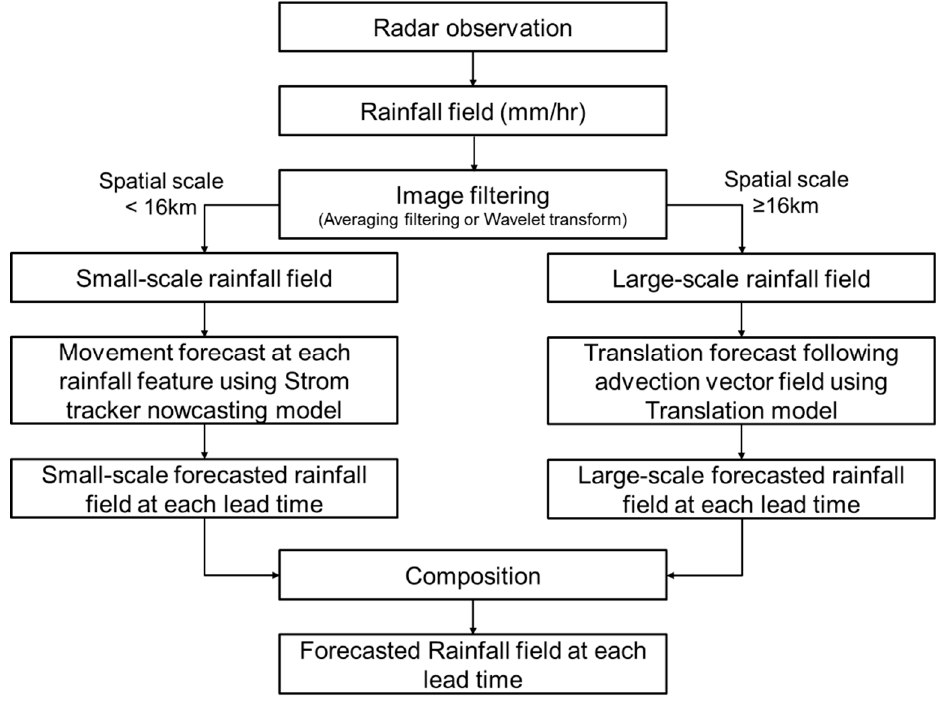
Figure 1. Flow chart of spatial-scale decomposition method used in this study; based on Yoon [15].